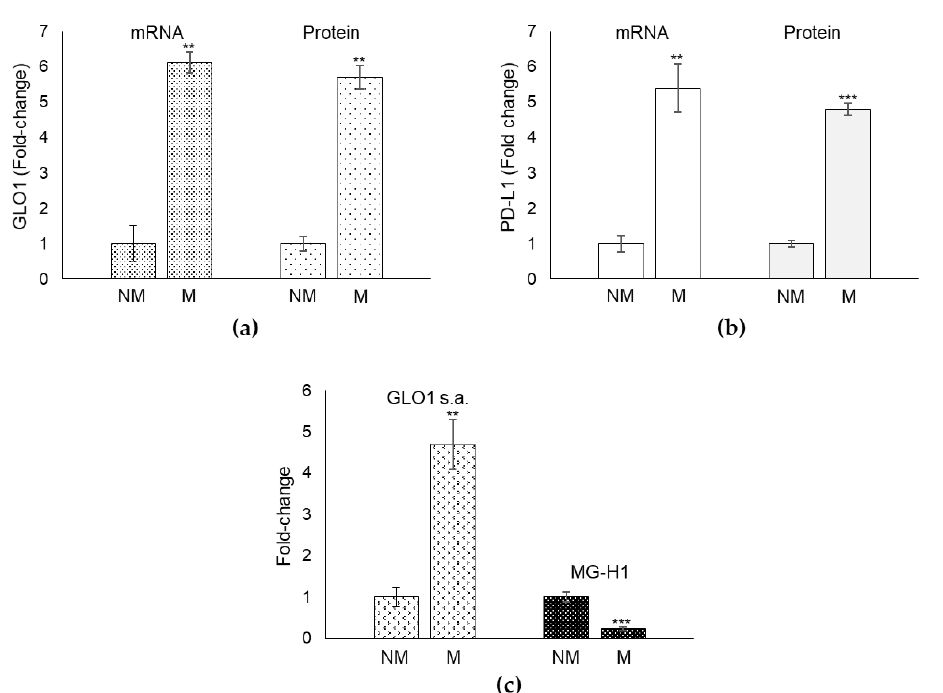
Figure 2. Glyoxalase 1 (Glo1) and PD-L1 mRNA expression in biopsies from metastatic PCa patients. ( a ) Glo1 expression, at mRNA and protein level, and ( b ) PD-L1 expression, at mRNA and protein level, in biopsy samples obtained from metastatic ( n = 30, stage M1) and non-metastatic PCa ( n = 30 of which 15 stage pT2, cancer confined to the prostate and 15 stage pT3, extra-prostatic extension and/or seminal vesicle involvement) patients. ( c ) Glo1 enzyme activity was measured in total protein extracts spectrophotometrically, while MG-H1 by a specific ELISA assay. ** p < 0.01; *** p < 0.001.